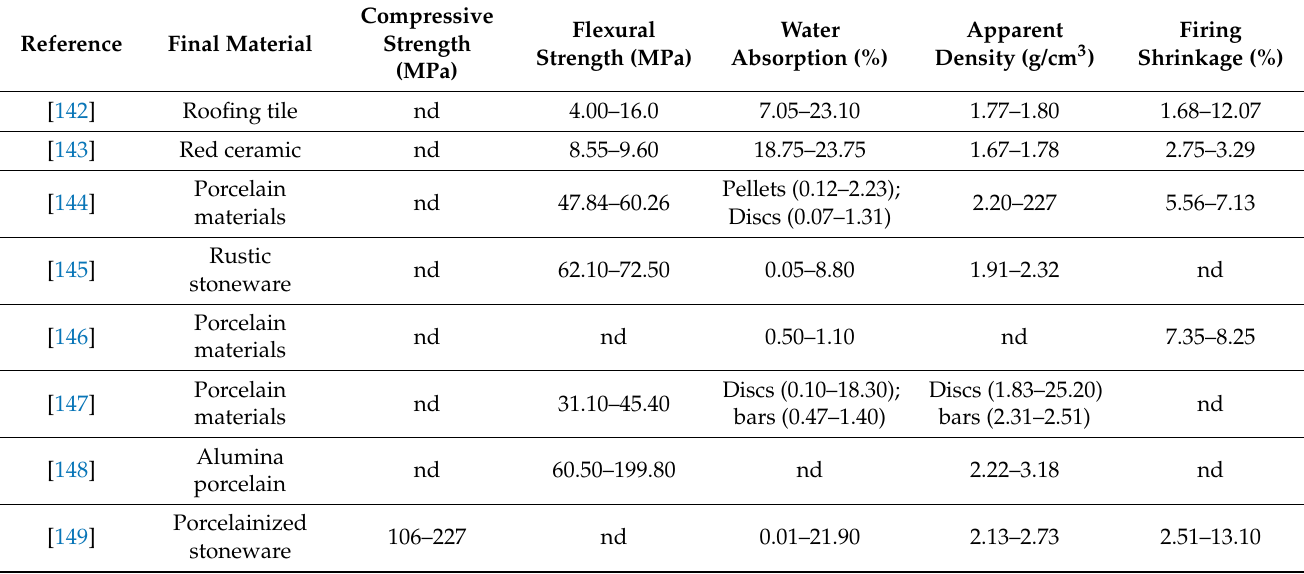
Table 21. Technological properties of mullite-based materials developed from granite